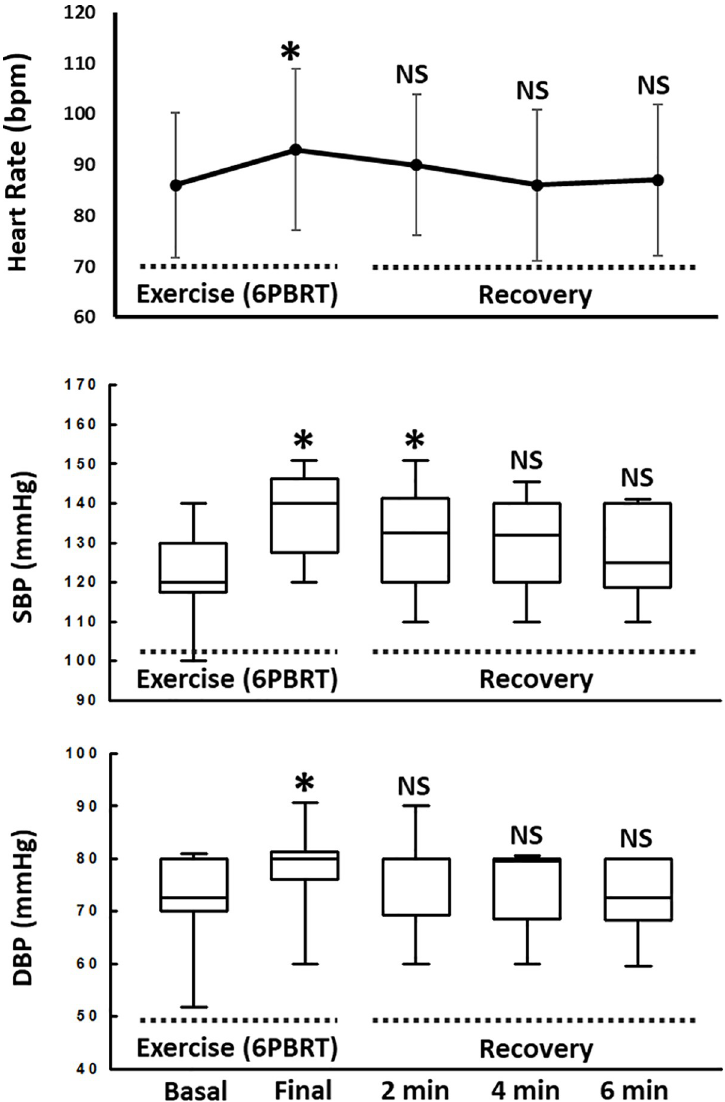
Fig 5. Heart Rate, systolic and diastolic blood pressure responses. Abbreviations: bpm, beats per minute; NS, not significant; 6-PBRT, six-minute pegboard and ring test; SBP, systolic blood pressure; DBP, diastolic blood pressure; min, minutes; � significant difference when compared to basal